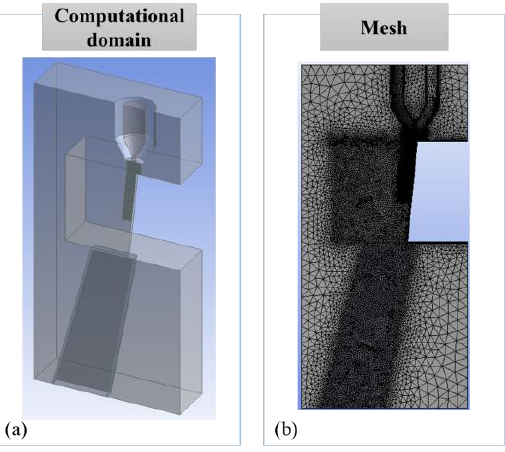
Figure 5. CFD model. ( a ) Computational domain and ( b ) Mesh model.